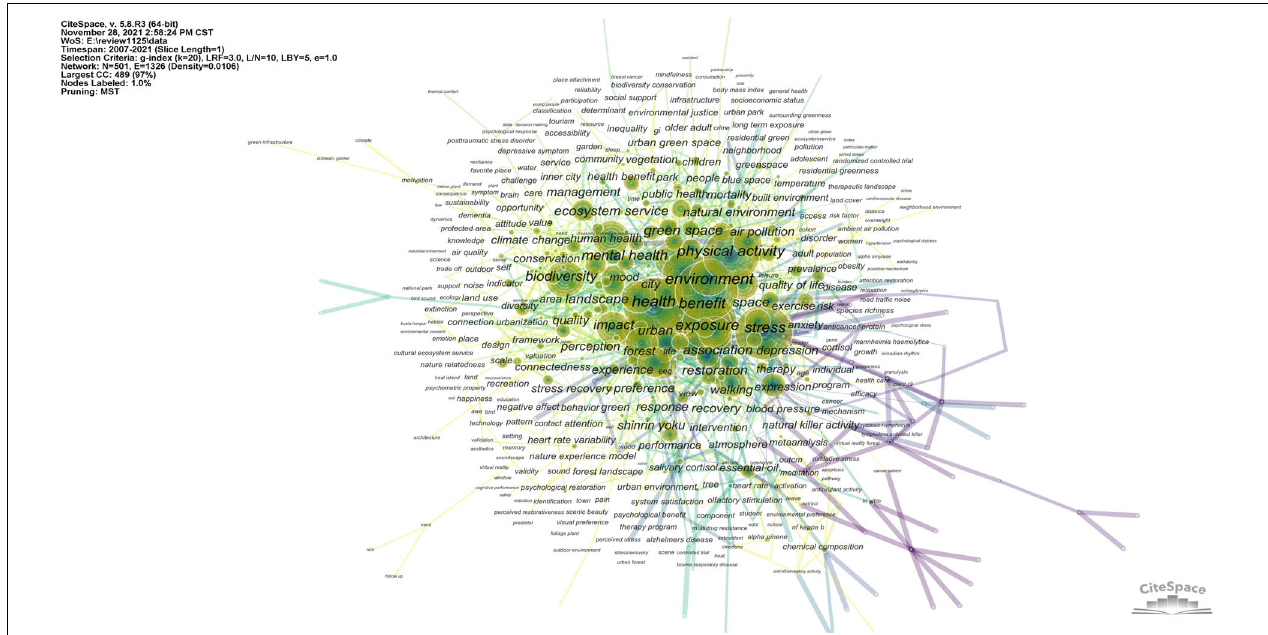
FIGURE 4 | Keyword co-occurrence visualization network.